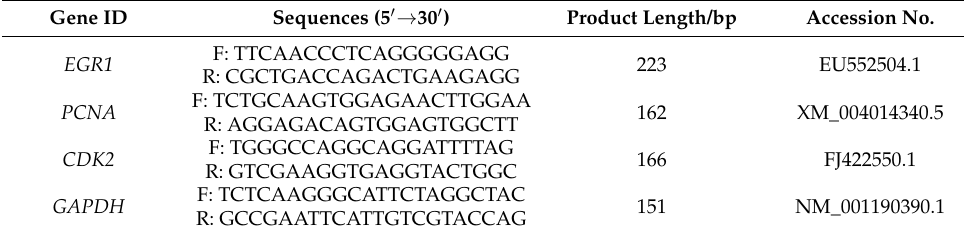
Table 2. The sequence information of genes for